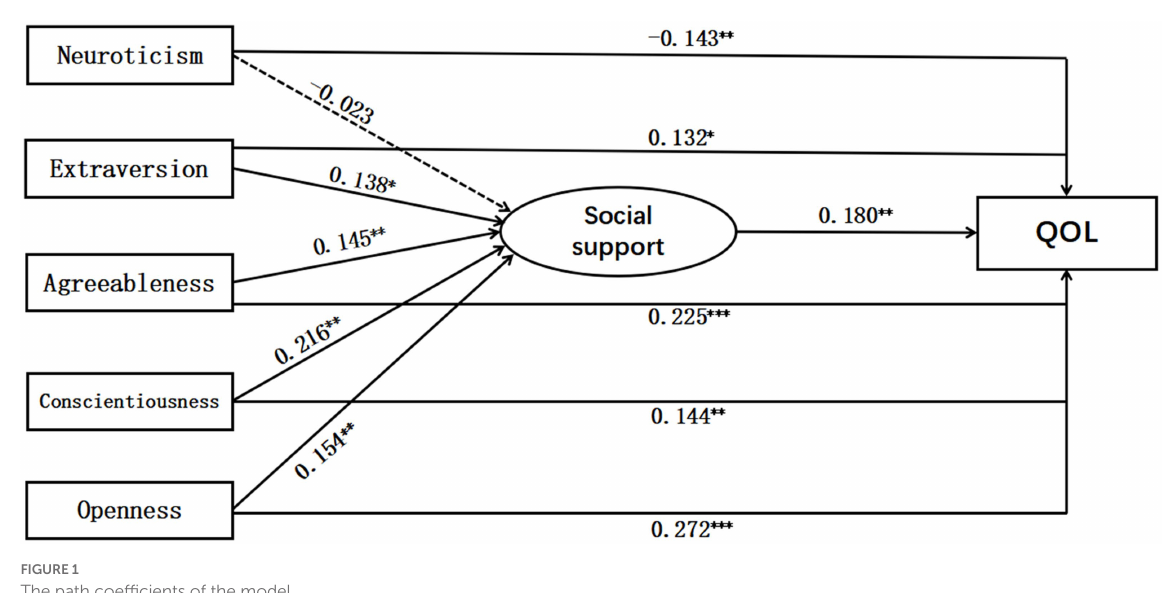
FIGURE 1 The path coefficients of the model.